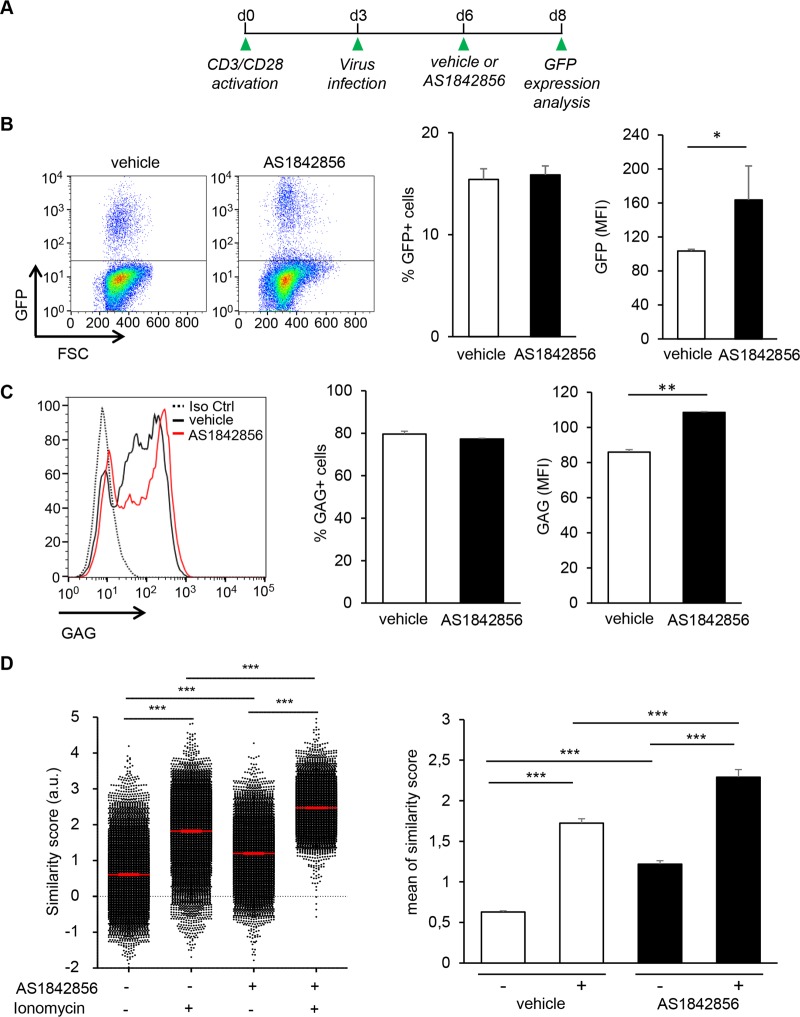
AS1842856 is a potent activator of HIV-1 LTR in human T cell.(A) Experimental design. PBT were stimulated for 3 days with anti-CD3/CD28 beads and then infected with a pseudotyped HIV-1 retrovirus encoding GFP. Three days after infection, AS1842856 (500nM) or vehicle only were added to the culture. GFP expression levels were measured by flow cytometry two days later. (B) Result obtained with one representative donor (left panel) and mean results +/- SE of GFP expression measured in the GFP-positive gated cell population of 4 different donors (right panel) are shown. (C) Chronically HIV-1 infected H9 cells were cultured three days with AS1842856 or vehicle only. At the end of culture, GAG expression level was analyzed by flow cytometry. Result obtained in one experiment (left panel) and mean results +/- SE of 3 independent experiments (right panel) are shown. (D) ImageStream analysis of nuclear localization of NFAT1 in PBT treated for 7 days with AS1842856 (500nM) or vehicle only, either at the steady state, or after a 30 min stimulation with the calcium ionophore ionomycin. Results obtained with one representative donor are shown in the left panel, with the red bars representing the mean +/- SE of similarity score of at least 3x103 individual cells (black dots) in each experimental condition. Mean +/- SE of these similarity scores obtained with 3 different donors are shown in the right panel.